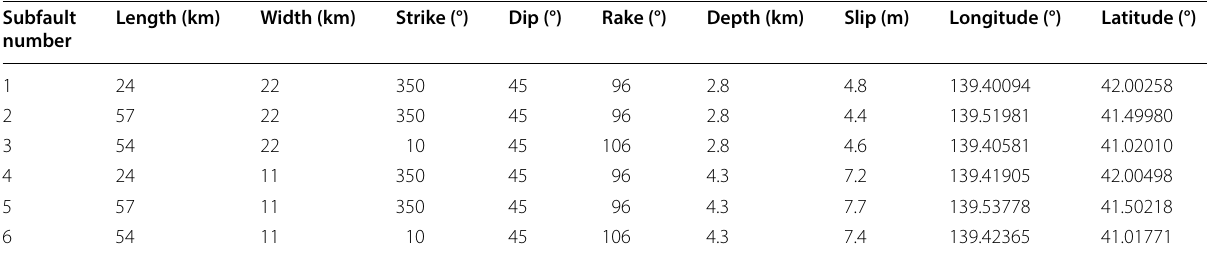
Table 1 Subfault model parameters of fault model F17 by the Hokkaido Disaster Management Council (2017) Subfault Length number